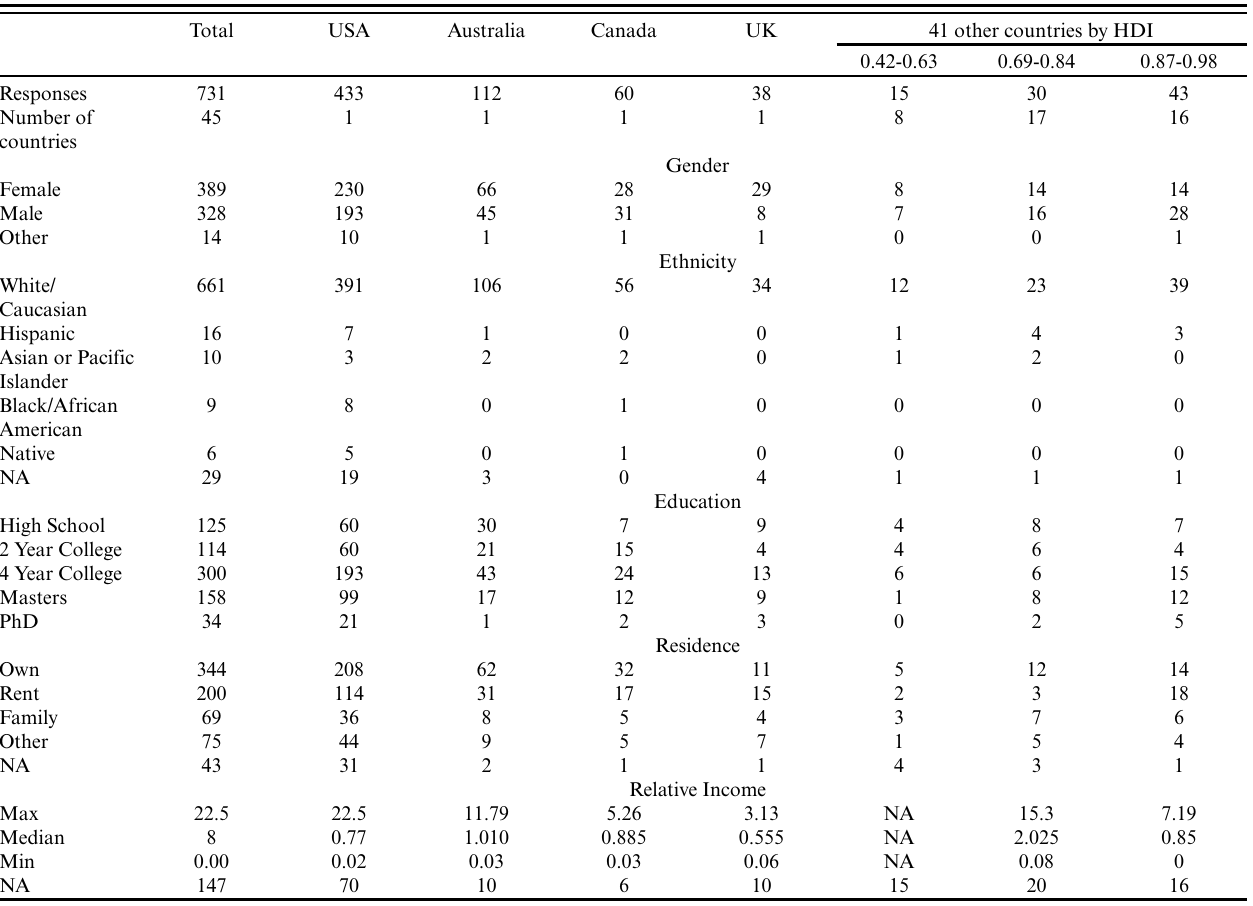
Table 1 . Demographic distribution among 731 permaculture survey respondents. The left-most column shows distribution in the total sample. The other two blocks of columns show responses from the four top-responding countries, and all other responses divided into three categories accorded to Human Development Index, respectively. (a) Gender responses are within 10% of a 1:1 male:female sex ratio for the total sample and most subgroups. No respondents identify their gender as other in either the low or middle other/HDI grouping. Of the top 4 responding countries, the highest level of respondents identifying gender as other are UK and USA (0.03 and 0.02, respectively), and the lowest is Australia (0.01). (b) Ethnicity: Every subgroup shows a white supermajority. The most diverse responses come from each of the three subgroups outside of the 4 top-responding (and white majority) countries. Despite white demographic dominance across subgroups, the proportional ethnicity of the permaculture movement appears to shift with regional ethnic context. (c) Education: Of the top four responding countries, Australia had the highest percentage of respondents who had not completed any post-high school degree (27%), followed by the UK (24%), the USA (14%), and Canada having the lowest percentage (12%). (d) The overall sample ratio of homeowners to renters (ignoring family and other categories) is 1.7:1, suggesting intermediate- to-high socioeconomic status. Among the four top-responding countries, Australia has the highest ownership:rental ratio at 2:1, and the UK the lowest at 0.73:1. (e) Relative income, or income as a proportion of the national median income: Missing values are created both by nonresponse and by lack of data on national median income, and thus all 15 potential responses in the lowest other/HDI category are missing. The median for the total and for 4 of the 6 subgroups is below the national median. This contrast with the other socioeconomic status indicators (that suggest intermediate-to-high SES) highlights the ways in which income may not be a powerful indicator of socioeconomic status in this context, due to conscious lifestyle choices among participants that may restrict income but do not necessarily alter other aspects of